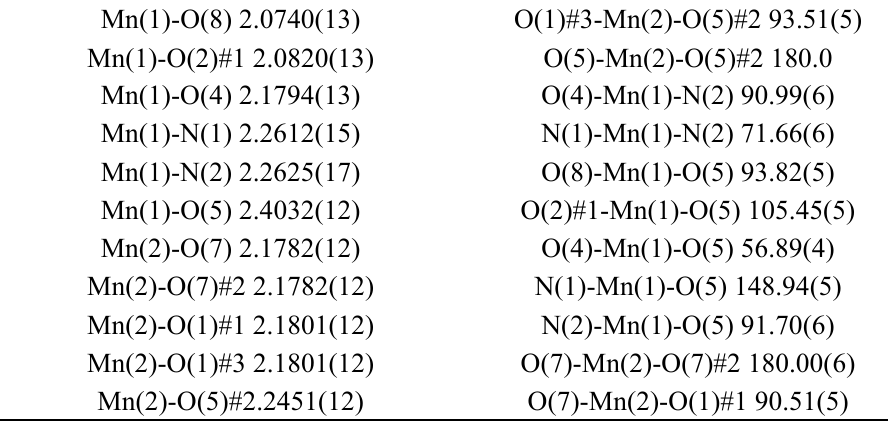
Table 2. The selected bond lenths (Å) and angles (°) for complex 1